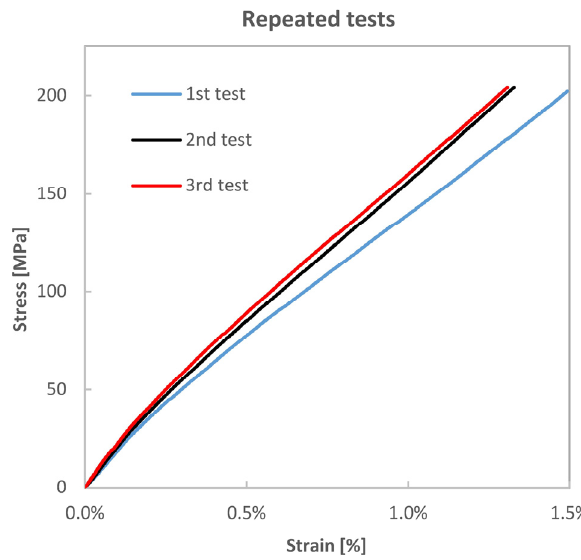
Figure 4. Evolution of the tensile curve for the same VB specimen retested after 24 h for three times.